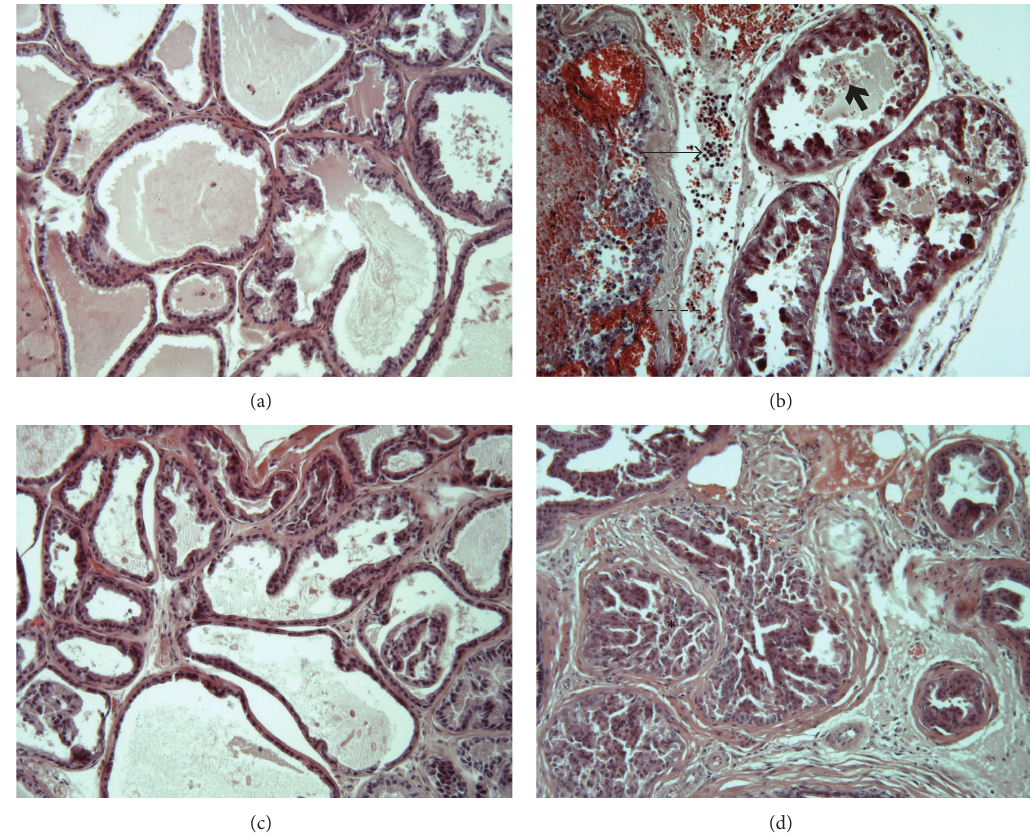
Figure 6: Instillation of the PAR1 activating peptide TFLLR-NH 2 diminishes ethanol- (EtOH-) + dinitrobenzene sulfonic acid- (DNBS-) induced microscopic damage in wild-type mice. Prostates were treated for 2 days with (a) sterile saline, (b) EtOH + DNBS (arrow indicates leukocyte recruitment, dashed arrow indicates hemorrhage, asterisk indicates acini destruction, and arrowhead indicates epithelial cell necrosis), (c) EtOH + DNBS + PAR1 activating peptide TFLLR-NH 2 (TF), and (d) EtOH + DNBS + PAR1 reverse peptide RLLFT-NH 2 (RL) (asterisk indicates acini destruction). All sections were stained with hematoxylin and eosin (H&E); original magnification